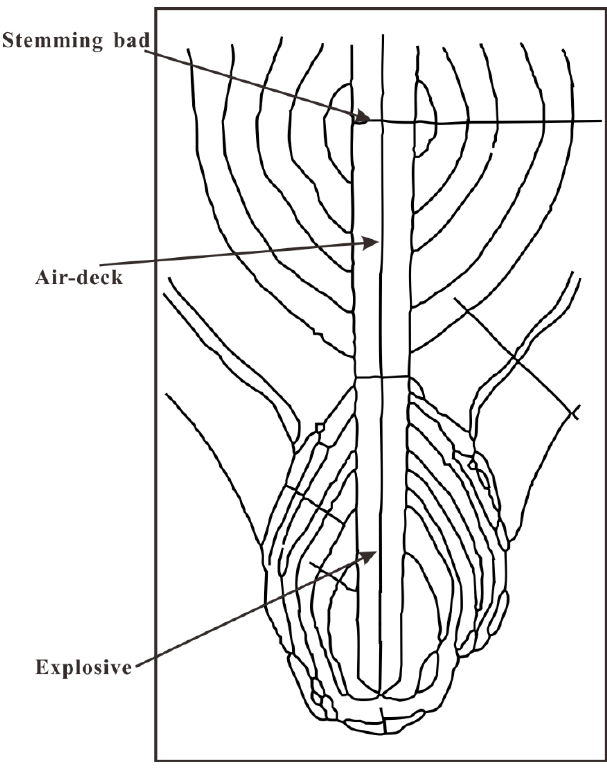
Figure 7. Fracture network development in thick Plexiglass [30].